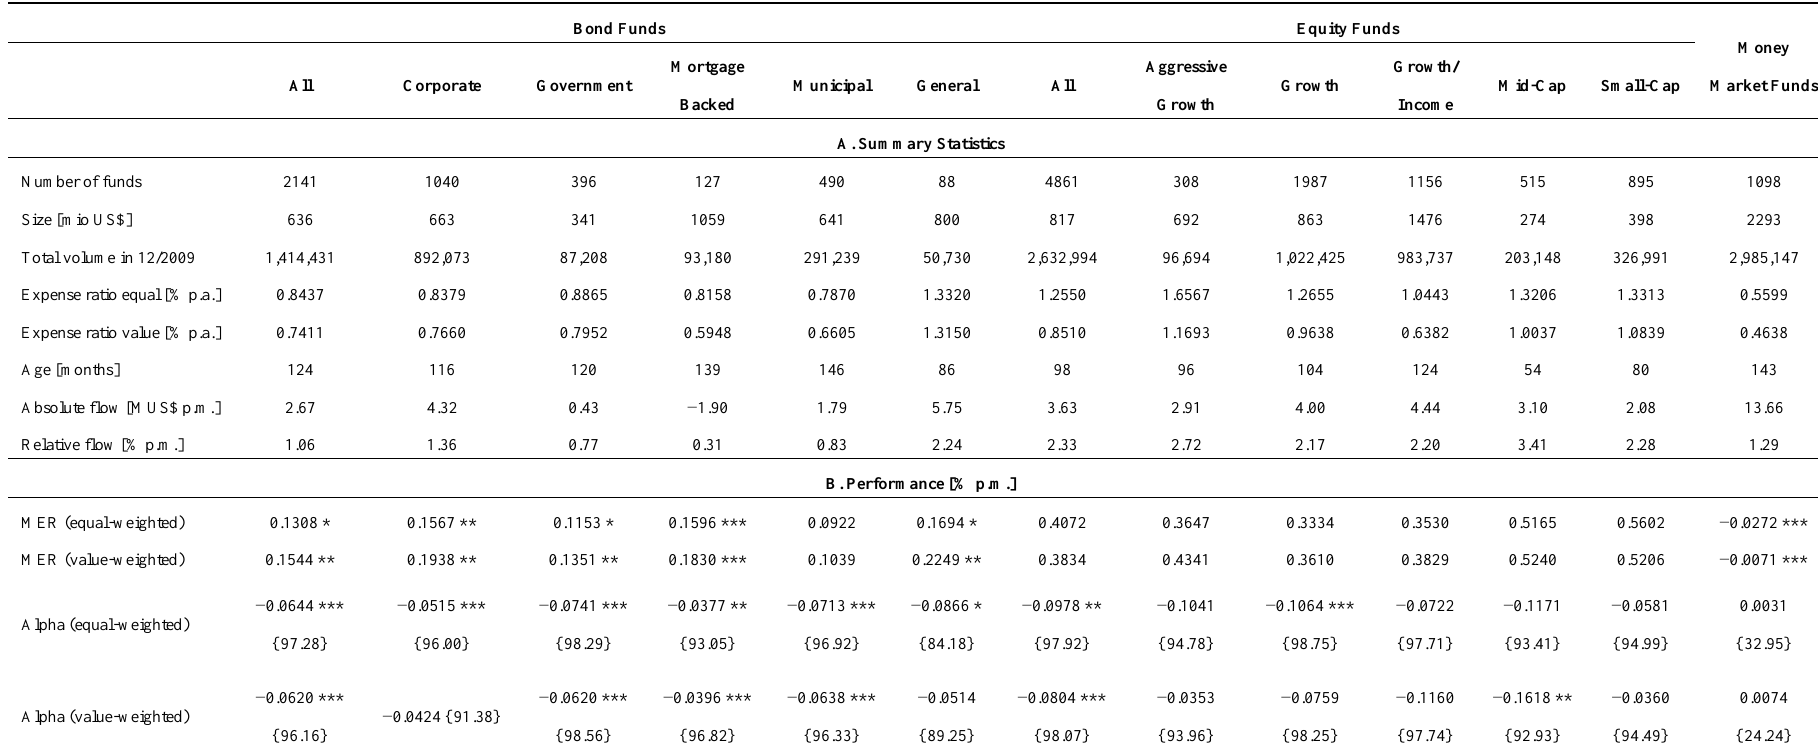
Table 2 . Summary Statistics and